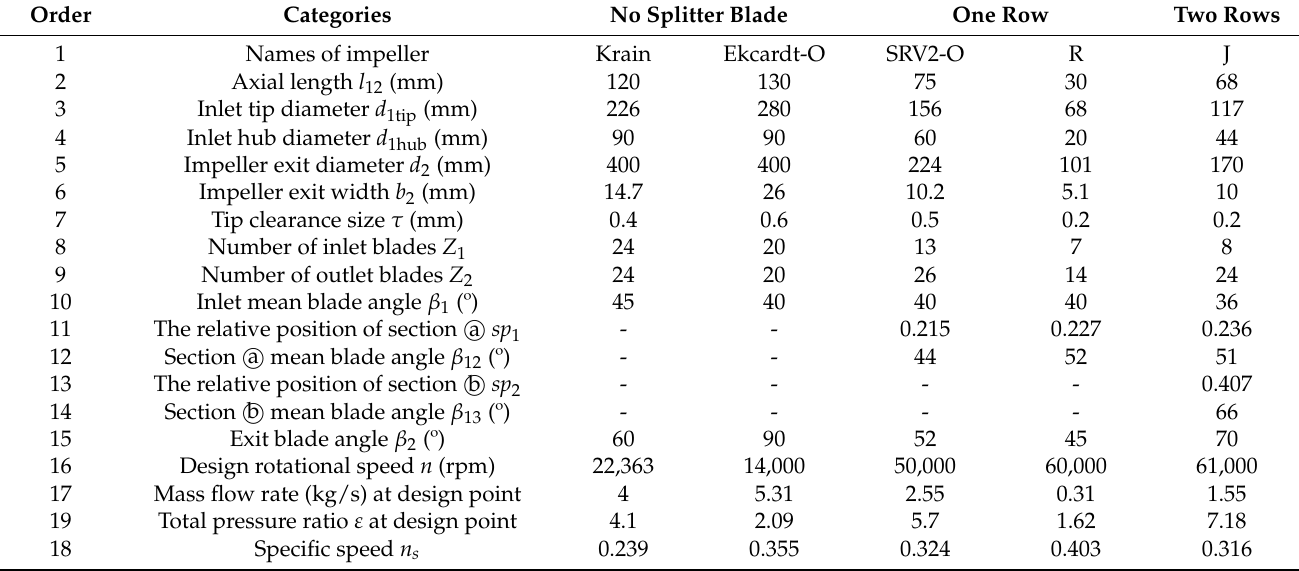
Table 1. Key parameters for the impeller